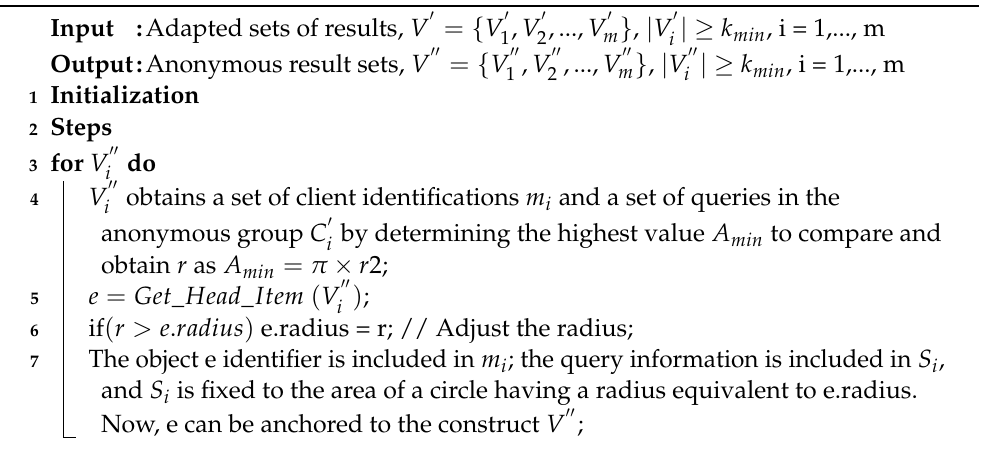
Algorithm 1: Generation of anonymous result